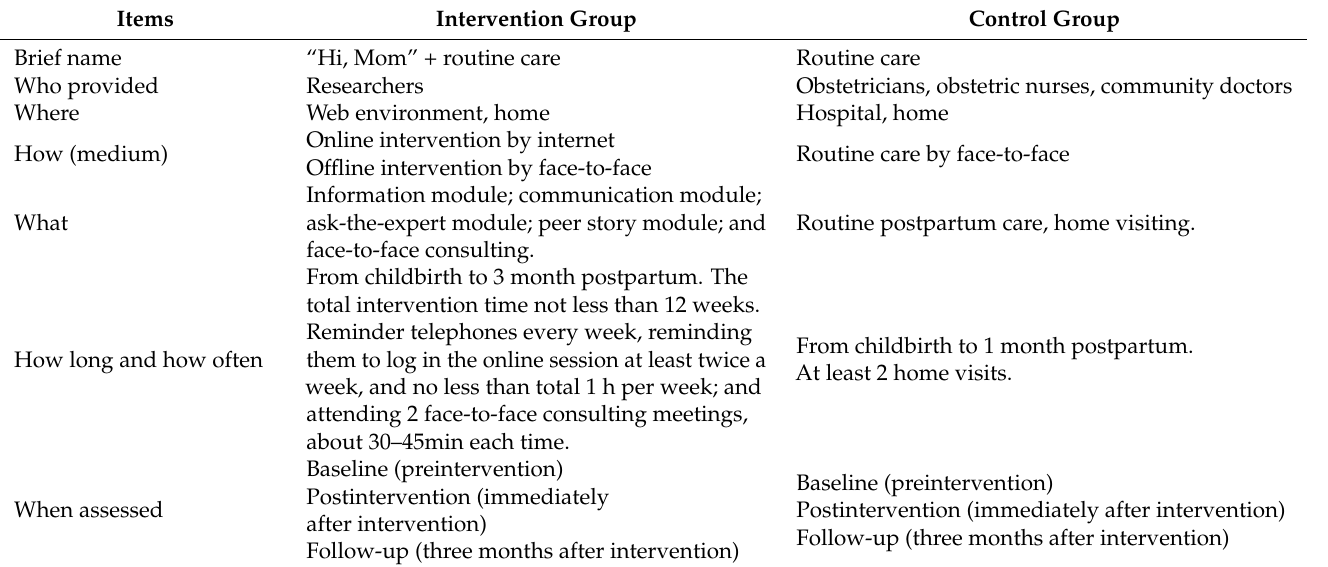
Table 1. The details of the “Hi, Mom”